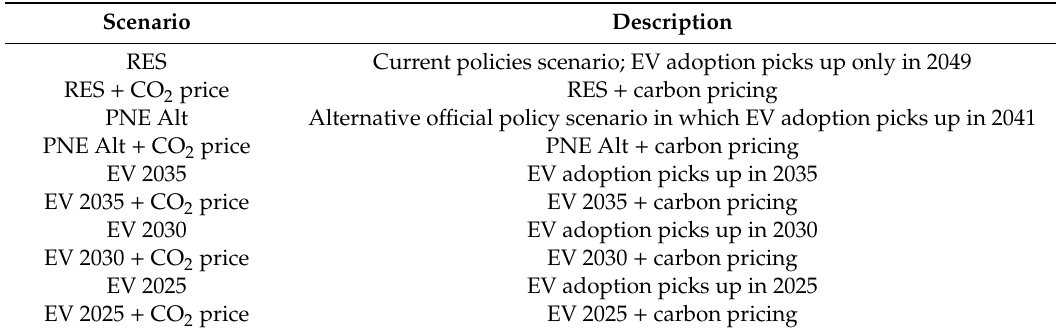
Table 5. Description of scenarios developed in this